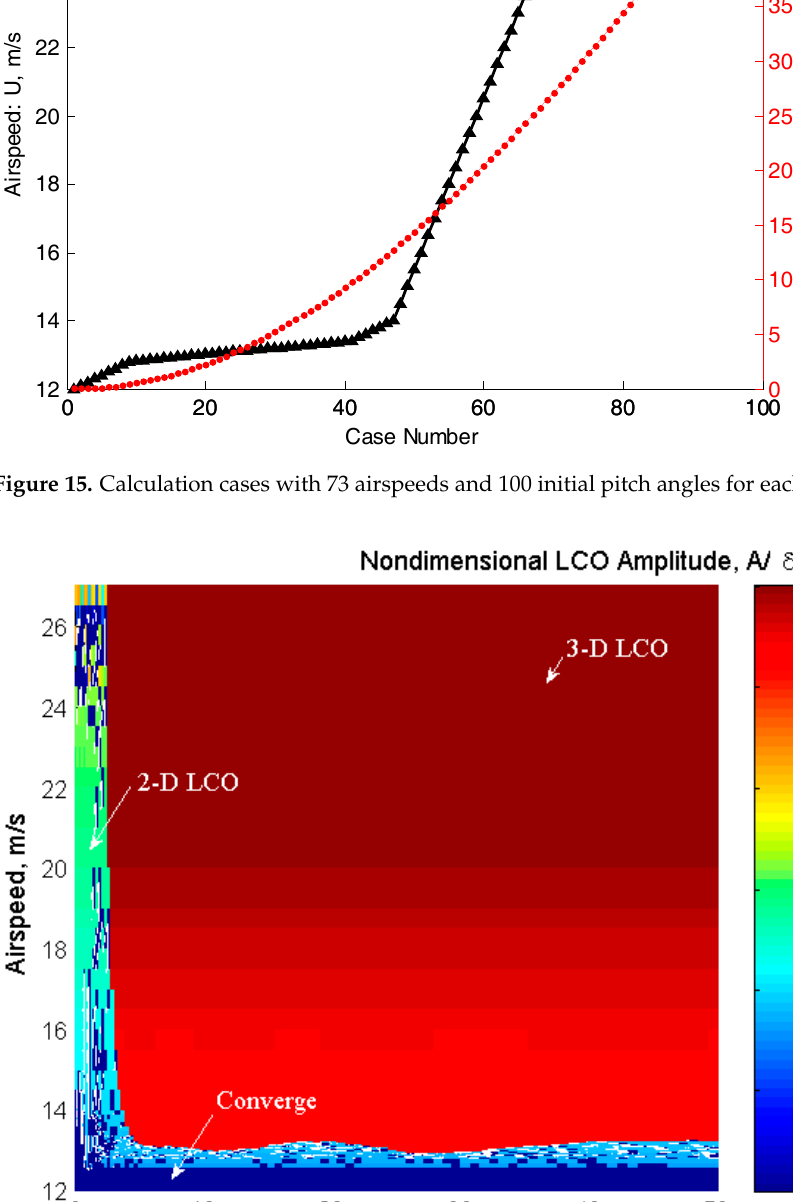
Figure 17. A close-up of Figure 16 which focuses on the airspeed from 12.4 to 13.8 m/s. Random switching between the 2-D LCO and convergence of the system responses can be observed as the initial pitch angle increases. 6. LCO Analysis of Time Integrations with the SSI Scheme 6.1. LCO Results under an Airspeed of 20 m/s In this section, we seek to find all possible LCO solutions using time integration with the proposed SSI scheme. The SSI scheme is introduced in Section 3. First, an airspeed of